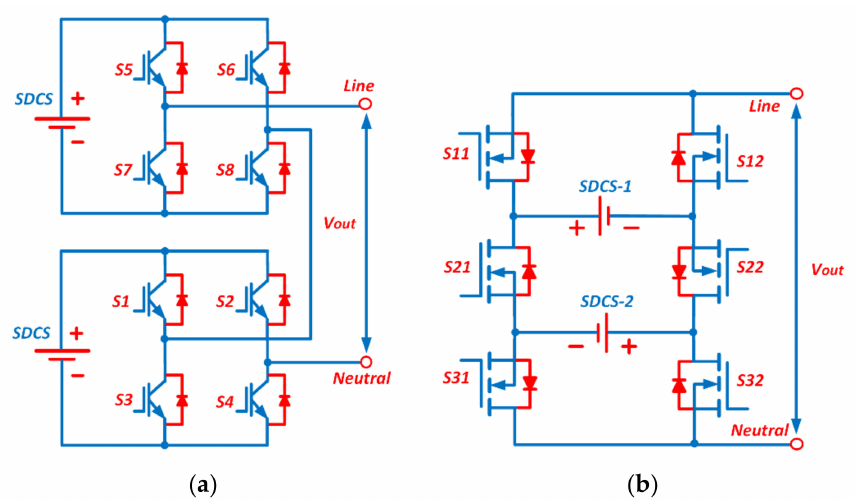
Figure 6. ( a ) Schematic of the MLI topology where each 4-switch block is considered an H-bridge. ( b ) The modified structure of a 5-level inverter that uses 6 switches instead of